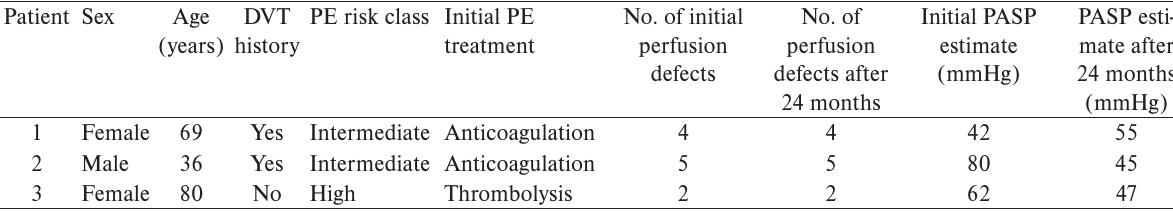
Table 2. Characteristics of CTEPH